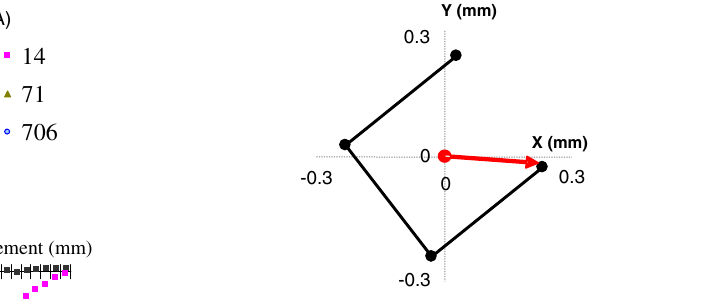
FIG. 18. (Color) Each dot is one measurement. The intrinsic offset ð (cid:2) x 0 ; (cid:2) y 0 Þ is represented by the vector. The circular rotation is performed by switching the cable on the upstream BPM side to the same readout channel. For the position mea- surement the Bergoz precision MX module is used.